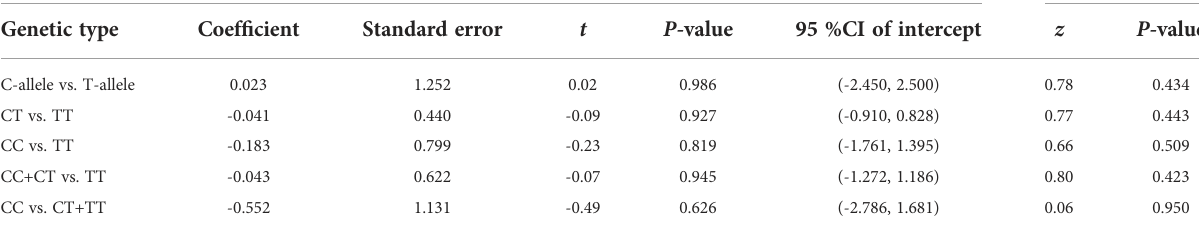
TABLE 2 Publication bias tests (Begg ’ s funnel plot and Egger ’ s test for publication bias test). Egger ’ s